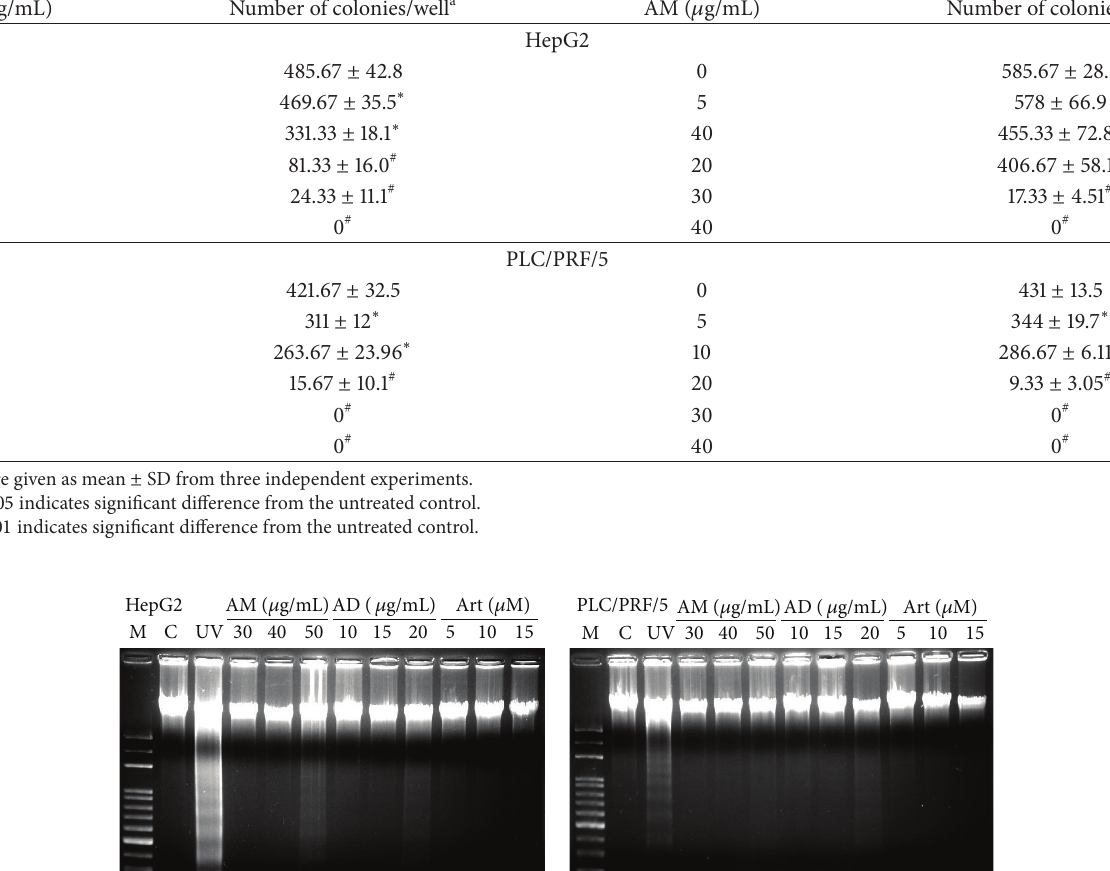
Table 1: Colony formation of long-term cell survival condition of HepG2 and PLC/PRF/5 after 9 days treatment of AM and AD. AD ( 𝜇 g/mL)